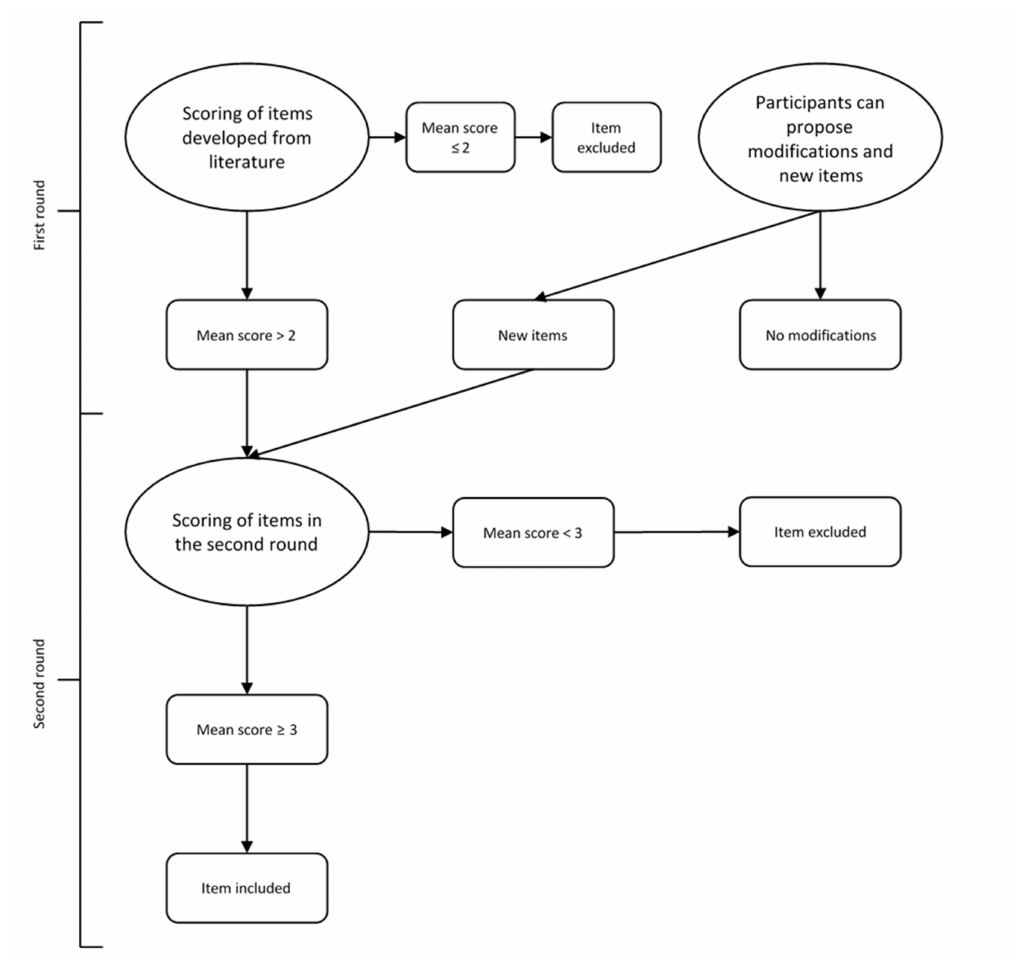
Figure 1. Flowchart of the selection procedure of the Delphi